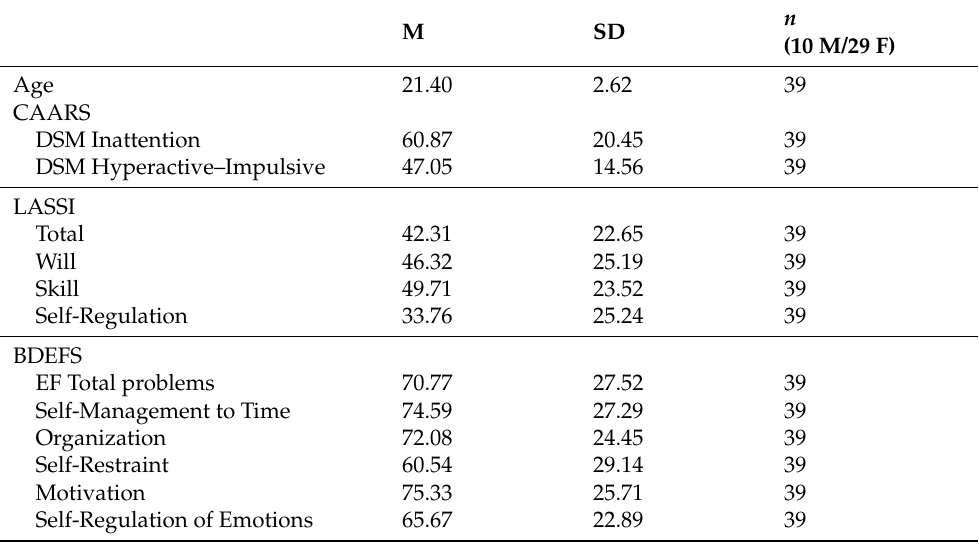
Table 1. Descriptors for age, attention deficit hyperactivity disorder (ADHD) symptoms, learn- ing/study strategies, and daily life executive function (EF) problems.